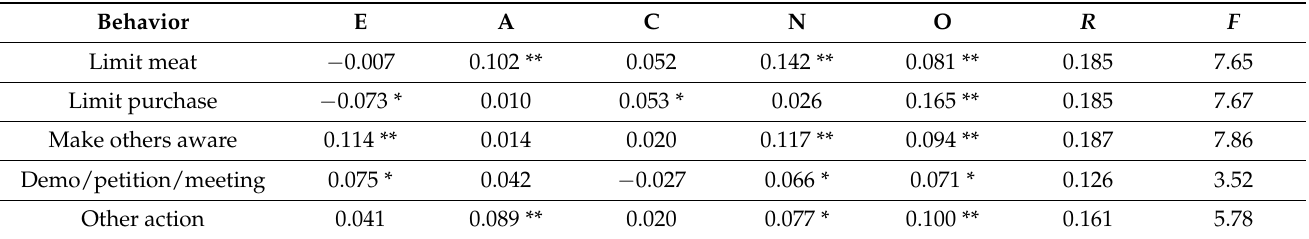
Table 2. Study 1: Relationships between personality and climate change mitigation